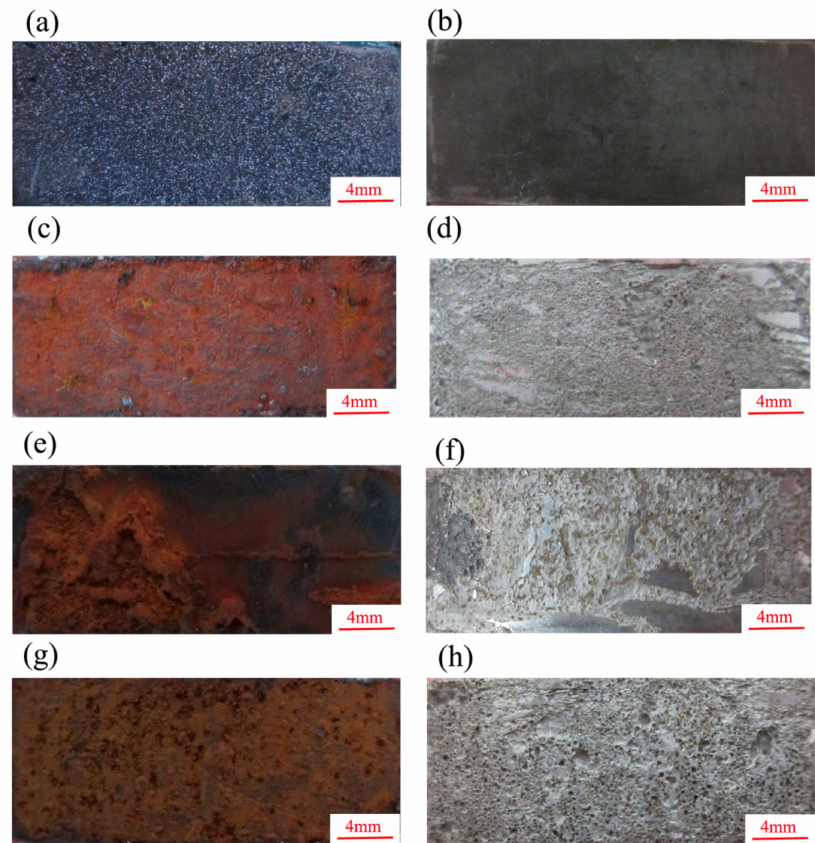
Figure 5. Macrostructure of erosion-corrosion products and substrates after removal erosion-corrosion products under di ff erent conditions ( a ) P CO2 : 2.5 MPa, erosion-corrosion product, ( b ) P CO2 : 2.5 MPa, substrate, ( c ) P CO2 : 2.5 MPa, P O2 : 0.2 MPa, erosion-corrosion product, ( d ) P CO2 : 2.5 MPa, P O2 : 0.2